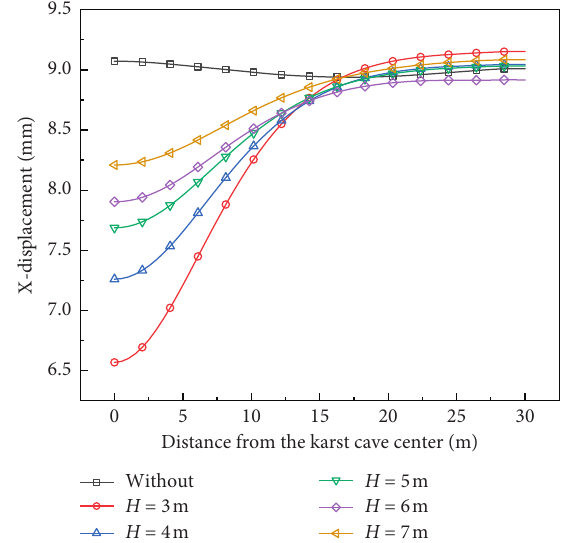
Figure 12: X-displacement curves of the tunnel waist with varying locations of the karst cave.